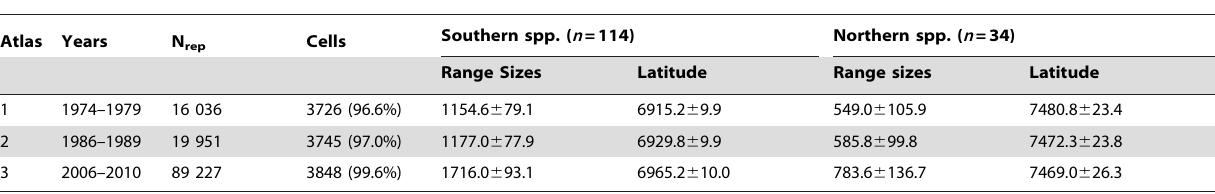
For each atlas, the total number of reports (N rep ) and the number of atlas cells surveyed (Cells) are given. A species’ national range size was estimated as the number of atlas cells occupied (not corrected for differences in the coverage). ‘Latitude’ is the weighted mean latitude of a species’ presence in each atlas, where weighting was